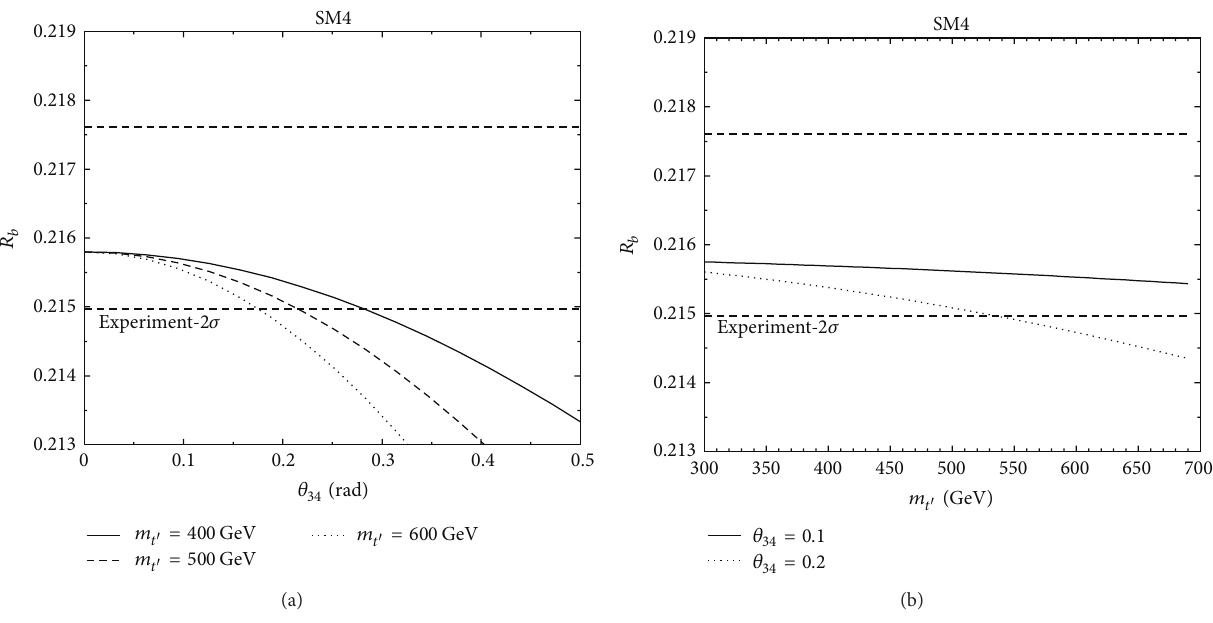
Figure 3: 𝑅 𝑏 in the SM4, as a function of 𝜃 34 for several values of the 𝑡 󸀠 mass (a) and as a function of 𝑚 𝑡 󸀠 for 𝜃 34 = 0.1 and 0.2 (b). Figure taken from